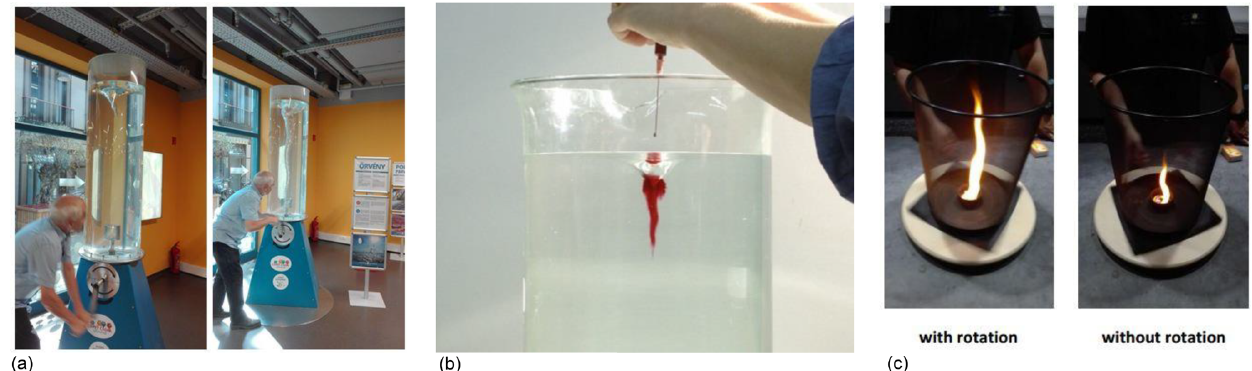
Figure 2. (a) A water whirl in a column of water, initiated by some paddles in the bottom of the vessel – made by the visitor itself (Center of Scientific Wonders). (b) A “tornado” in a rotating vessel filled with water (Kármán Lab, ELTE). The paint dropped into the vessel shows its structure. A short film about this can be found at http://scilwg.elte.hu/2018/EMS/film/6494_75s.wmv (last access: 18 July 2019). (c) A fire whirl, which was shown during an experimental demonstration to the visitors – whirl with and without rotating the plate below the cylindrical wire mesh (Center of Scientific Wonders) (all of these photos by A.